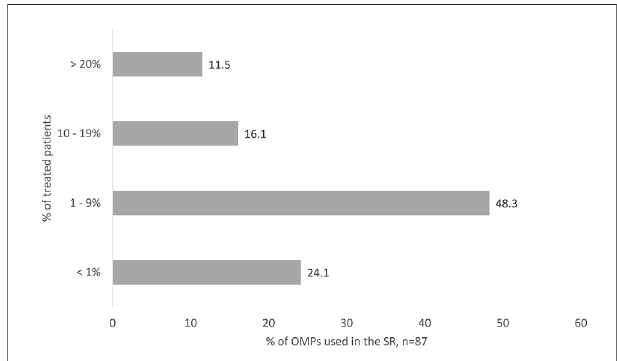
FIGURE 5 | OMPs accessed in the SR, classi fi ed according to the percentageoftreated patients. ThePercentage iscounted outofthepatients ’ number theoretically estimated from the prevalence in orphan designation at the time of marketing